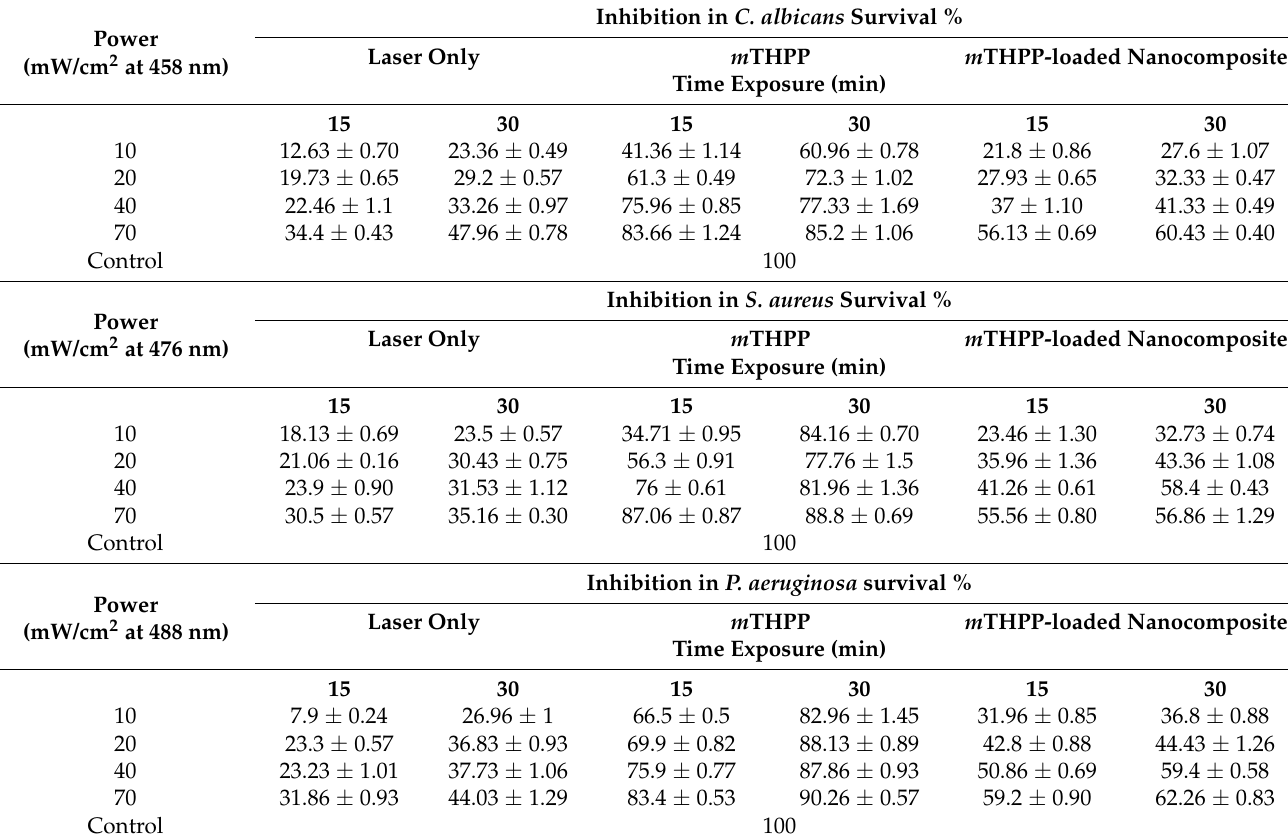
Table 4. Antimicrobial photodynamic therapy of m THPP and the m THPP-loaded nanocomposite at certain wavelengths with different irradiation